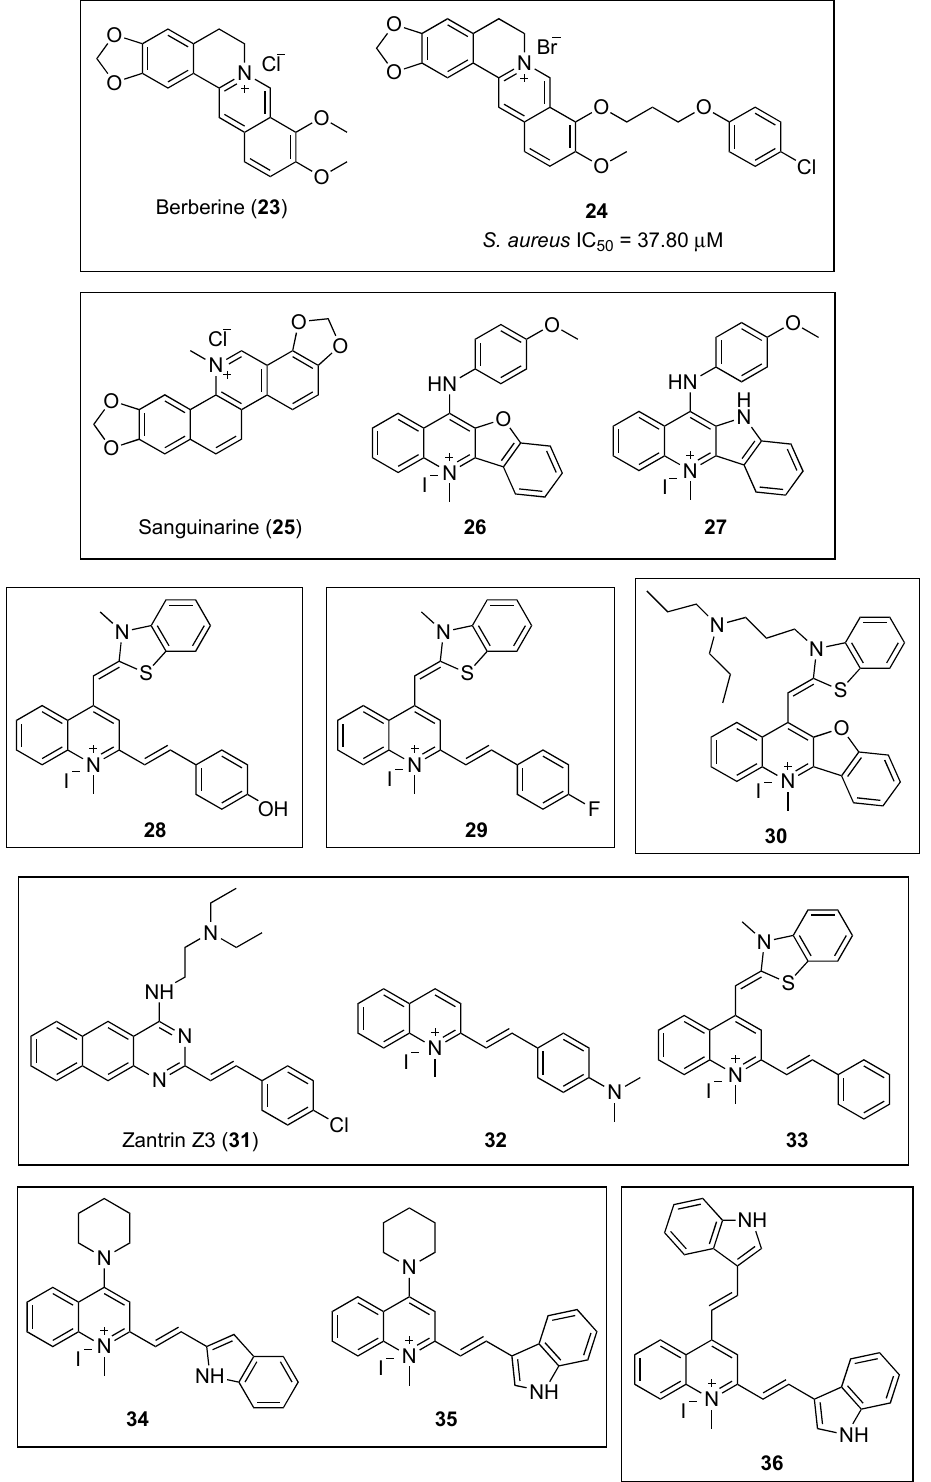
Figure 6. Chemical structures of the quinolinium and structurally related compounds.